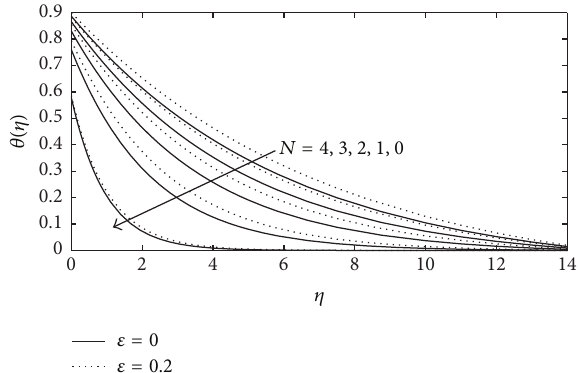
Figure 6: Effect of Prandtl number on temperature distribution when 𝐾 = 1 , 𝑊 𝑠 = −1 , Re = 100, Kn = 0.05, and 𝑁 = 1 .